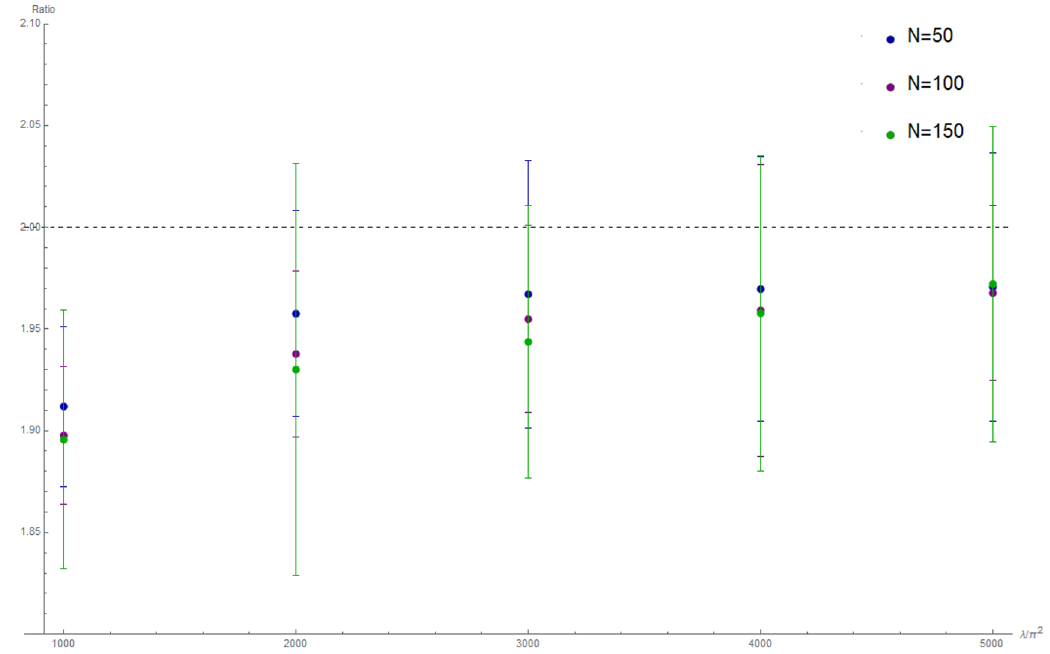
Figure 7 : Ratio between the 2-point function (5.17) for n = 3 in the circular quiver with M = 4 and those found in the circular quiver with M = 2 , in the range 1000 π 2 ≤ λ ≤ 5000 π 2 and for N = 50 , 100 , 150 . The expected ration in this case is 2